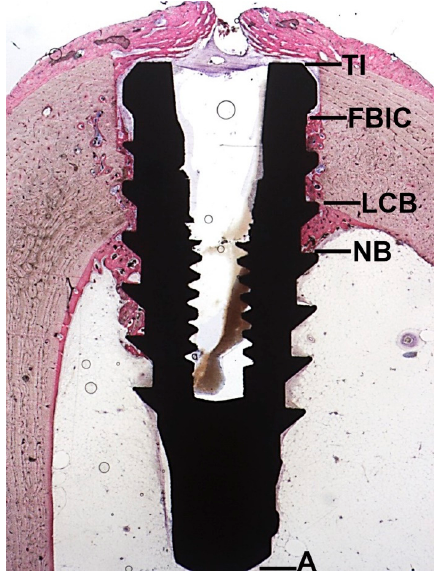
Figure 3. Histological image illustrating the landmarks for the histological evaluation. Top of the implant (TI); first bone implant contact (FBIC); lower portion of the cortical bone (LCB), most apical newly formed bone in contact with the implant (NB); apex of the implant (A).